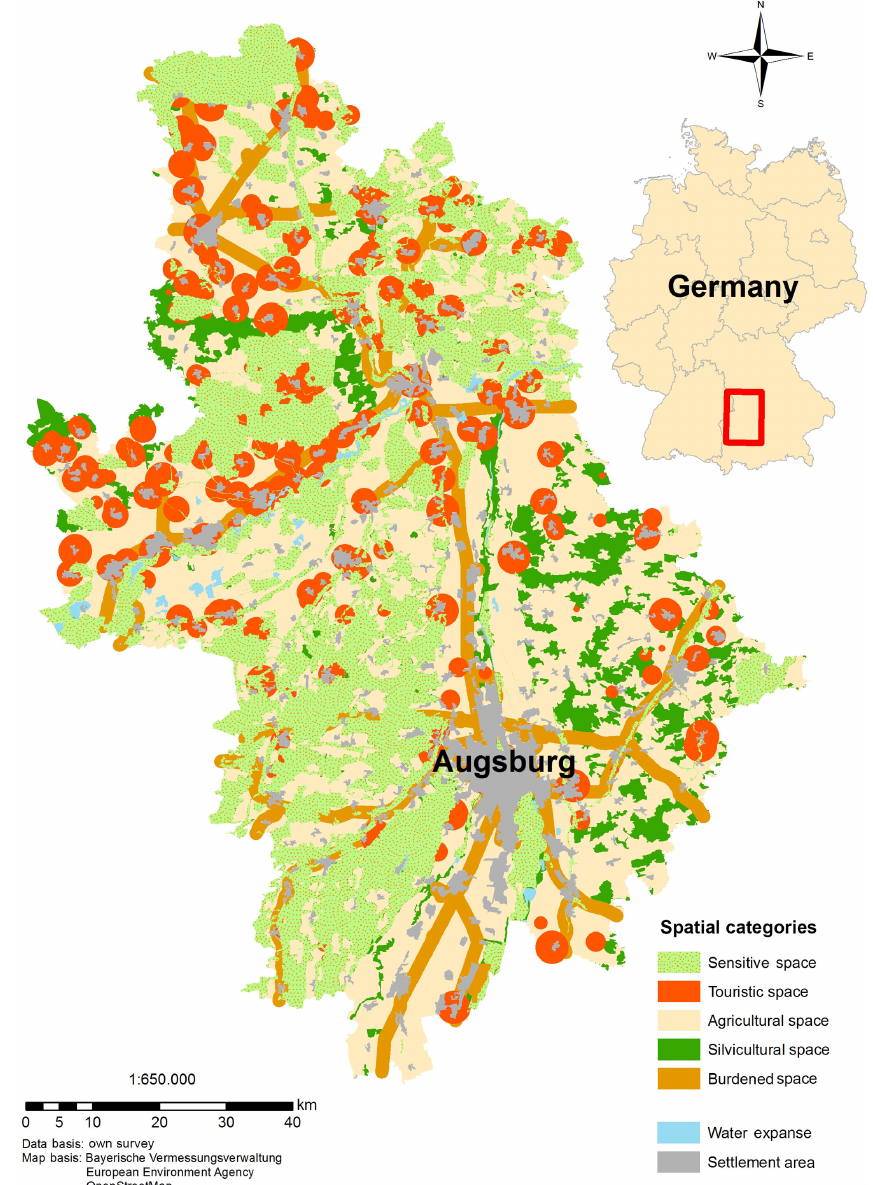
Figure 1. Subspaces of the planning